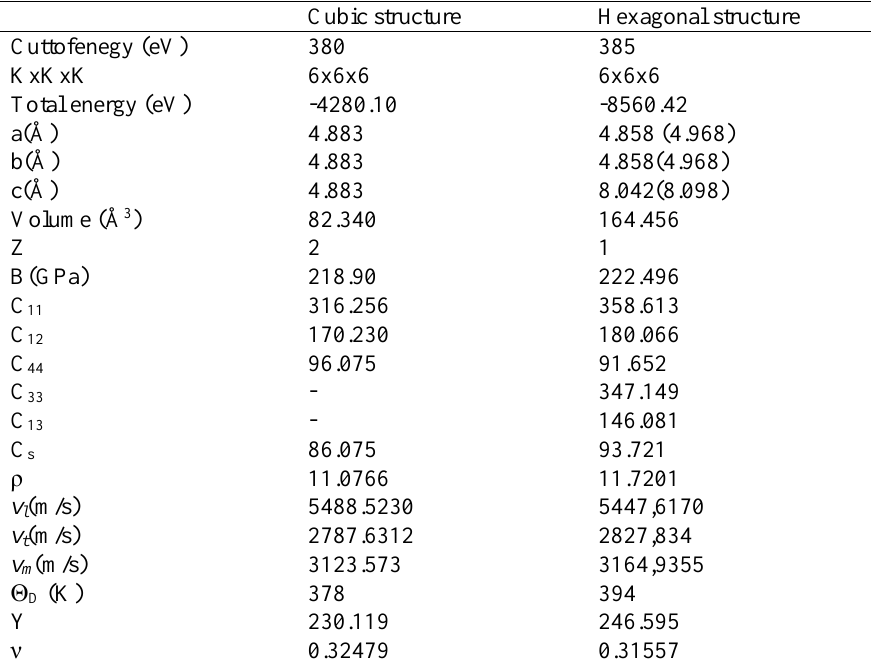
Table 1. The calculated lattice constant (Å), volumes (Å 3 ), bulk modulus, elastic constants, shear modulus, Young’s modulus, B/G ratio, density, sound velocities, and Debye temperature for (c- h)- Fe 2 Hf structures. Cubic